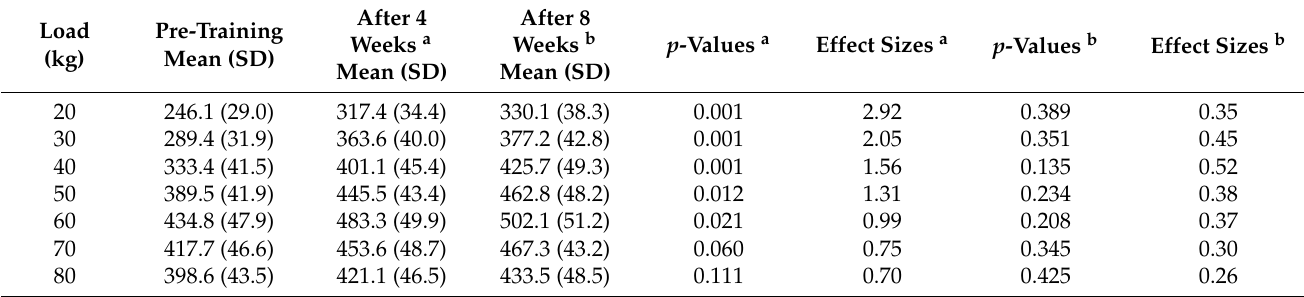
Table 3. Mean power (W) during squats on a BOSU ball prior to and after 4 and 8 weeks of instability resistance training.